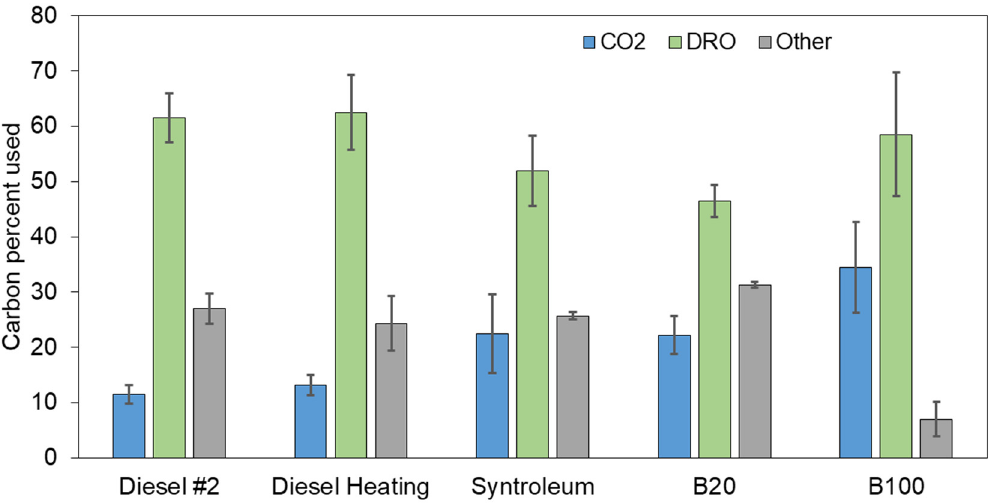
Figure 1. Percent carbon mass balance for different fuel types at the end of the experiment based on respiration (CO 2 ) and Diesel Ranges Organics (DRO) measurements by GC-MS. Conditions: 20 °C; 300 mg N, 1 kg of sand; 2000 mg of diesel, heating diesel, Syntroleum, B20, and pure fish biodiesel (B100). Values represent means ± SE.